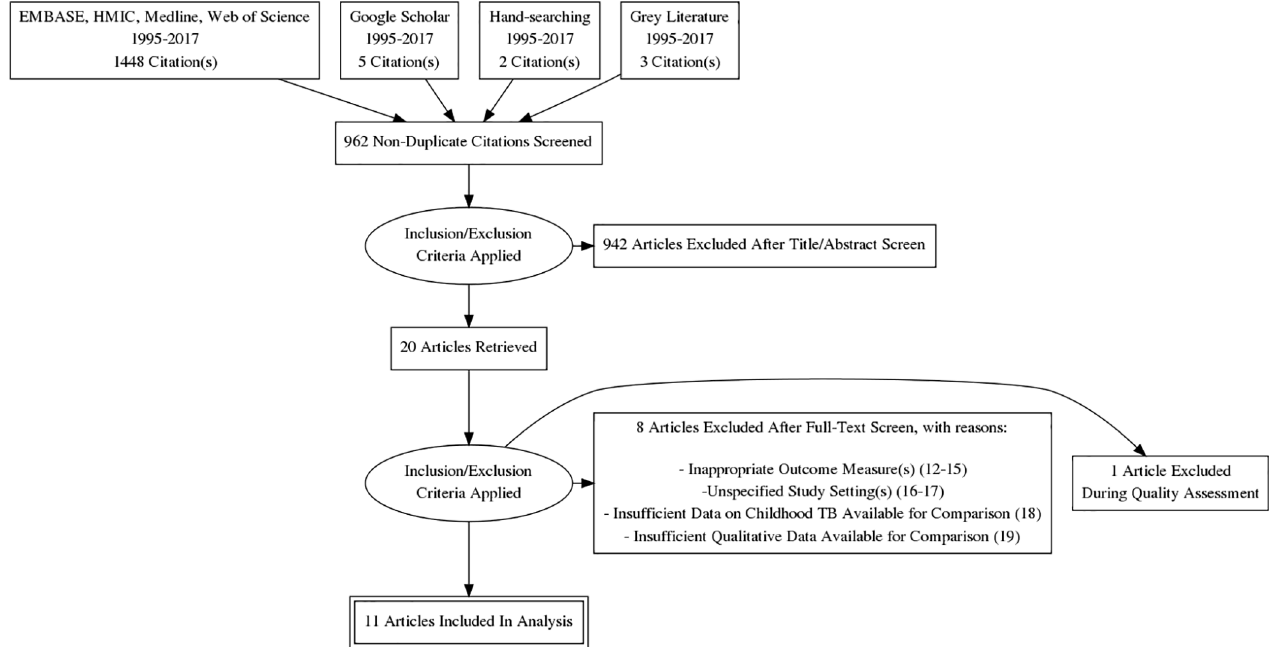
Fig 1. PRISMA flow chart. PRISMA flow chart outlining the search procedure for selecting studies on knowledge and practices in relation to TB care for the systematic review.